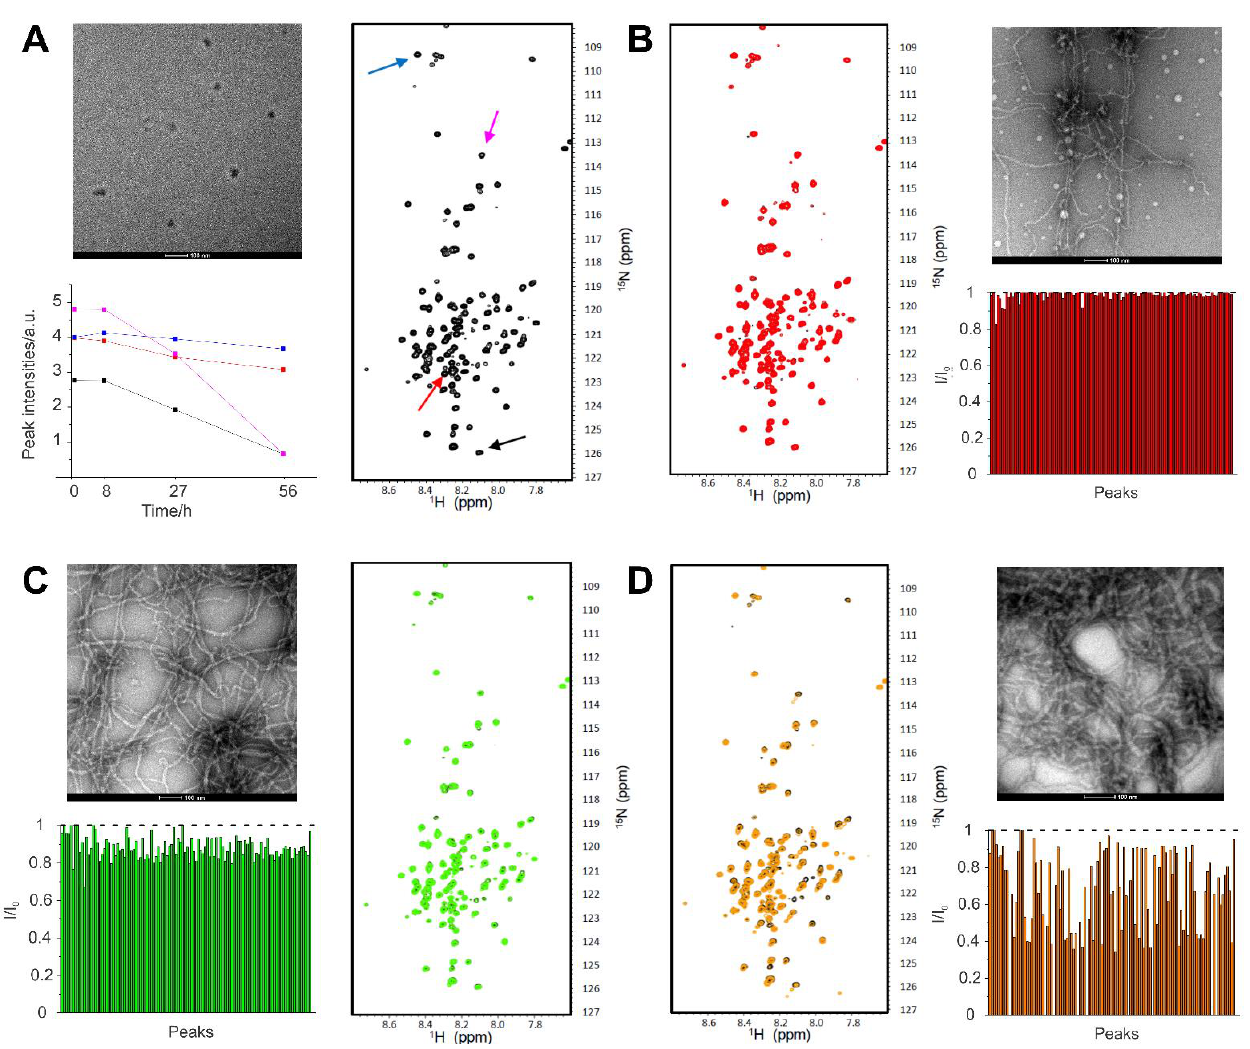
Figure 8. 1 H- 15 N HSQC spectra of a 100 μM PNT3 sample in 50 mM phosphate buffer at pH 6.5 , 5 mM EDTA after 0 ( A, black), 8 ( B, red), 27 ( C , green), and 56 ( D , orange) h of incubation at 37 °C. The HSQC spectrum of the sample at time 0 is shown in black in all panels. The peak intensities ratio between the amide protons signals of the sample recorded after 8 ( B ), 27 ( C ), and 56 ( D ) h of incubation at 37 °C, and those of the sample at time 0, are shown on the sides of panels B, C, and D, respectively. The intensity variation of four representative peaks is shown in the plot present in panel A and the associated peaks are indicated by arrows in the spectrum. The spectra were recorded at 310 K. Insets: negative-staining TEM micrographs of a PNT3 sample at 200 μM incubated at 37 °C for 0, 8, 27, and 56 h in the same buffer.